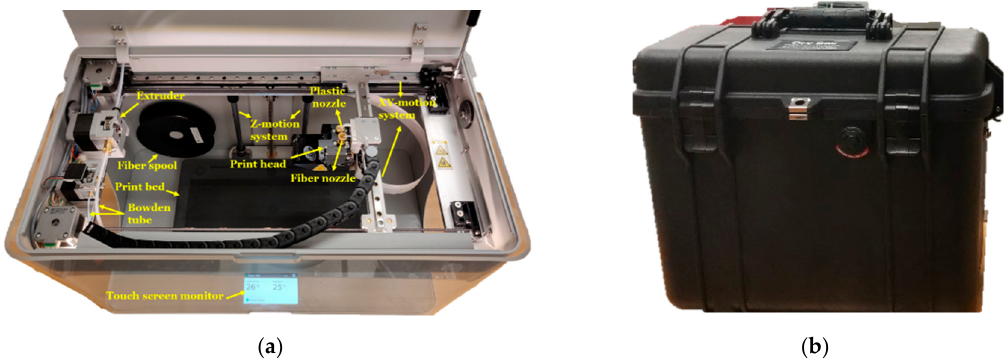
Figure 1. Mark Two 3D printer (desktop series) ( a ) and dry box to store and supply plastic filaments ( b ).